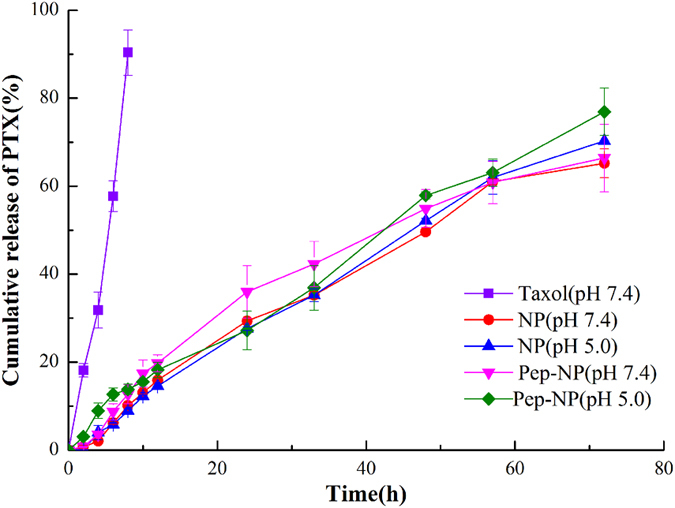
Paclitaxel release profiles from NP and Pep-NP in PBS (pH 5.0) and PBS (pH 7.4) containing 0.1% Tween-80.